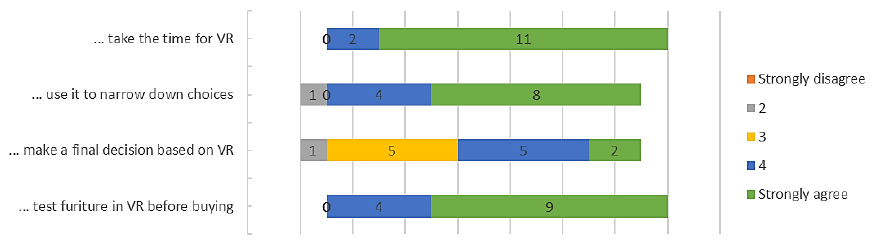
Figure 22. Answers of the participants regarding the personal attitude towards the system.